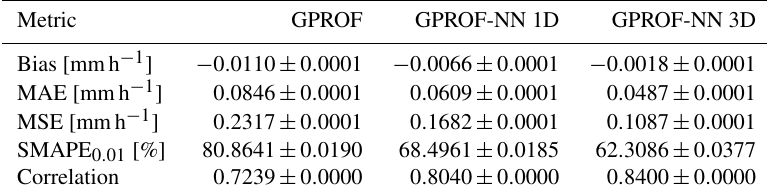
Figure 6. The same as Fig. 5 but for MHS. Table 5. Mean error metrics and estimated standard deviation for surface precipitation retrieved from MHS